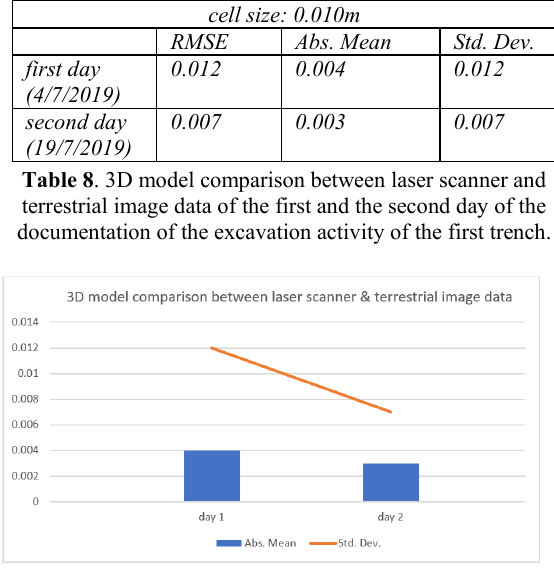
Chart 3 . 3D model comparison between laser scanner and terrestrial image data of the first archaeological trench (apart of the vertical sides) during the first day (4/7/2019) and the second day (19/7/2019) of the